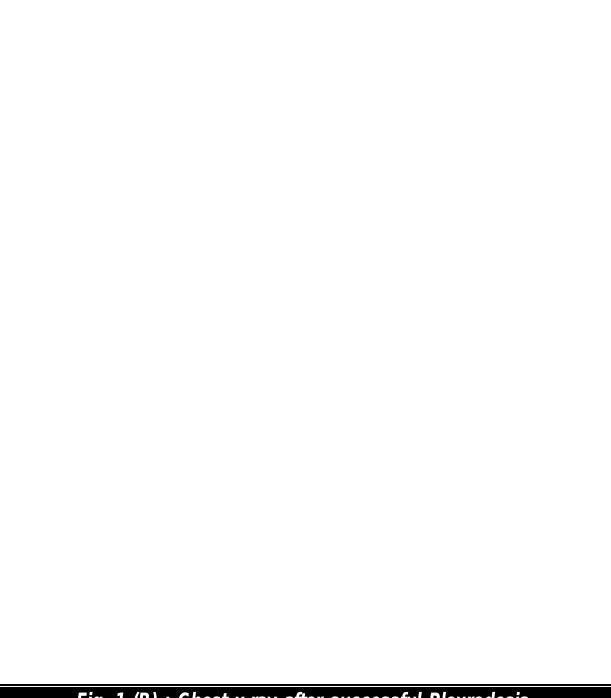
Fig. 1 (B) : Chest x-ray after successful